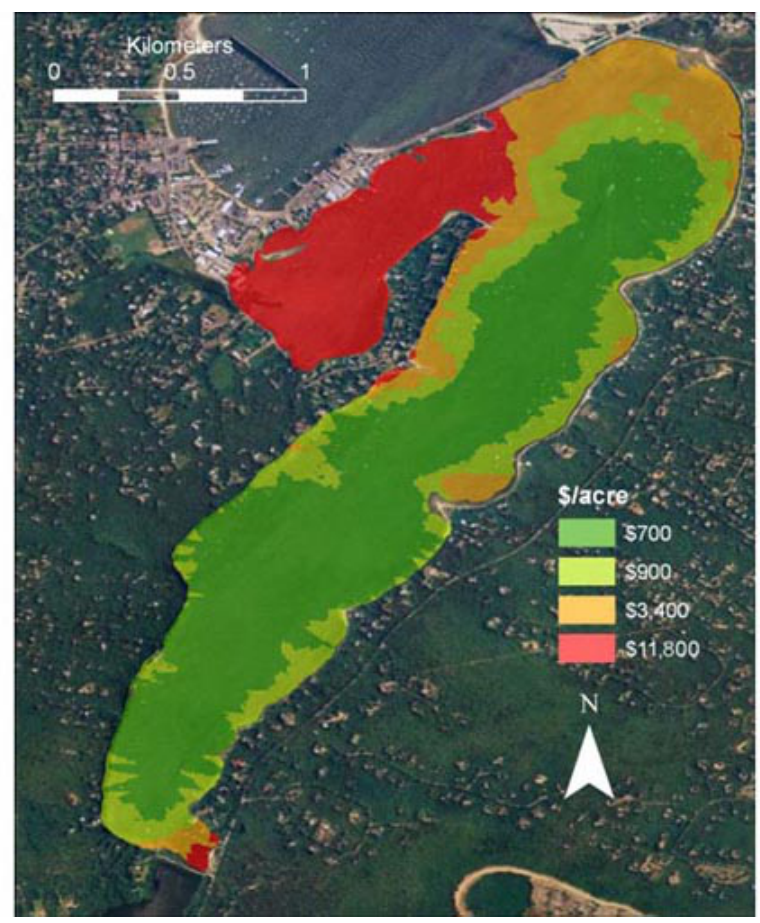
Fig. 5. Distribution of ecosystem service habitat value of bay scallop commercial and recreational fisheries based on depth distribution and interpolated